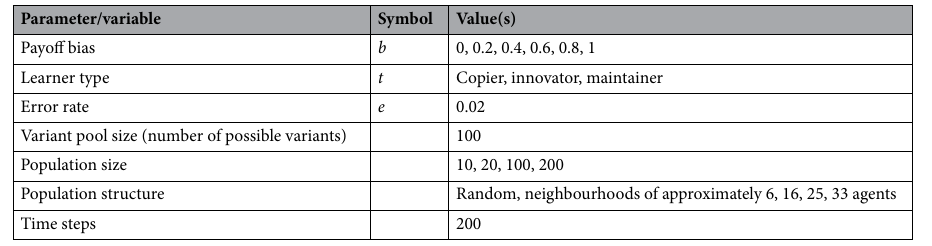
Table 1. Model parameters and